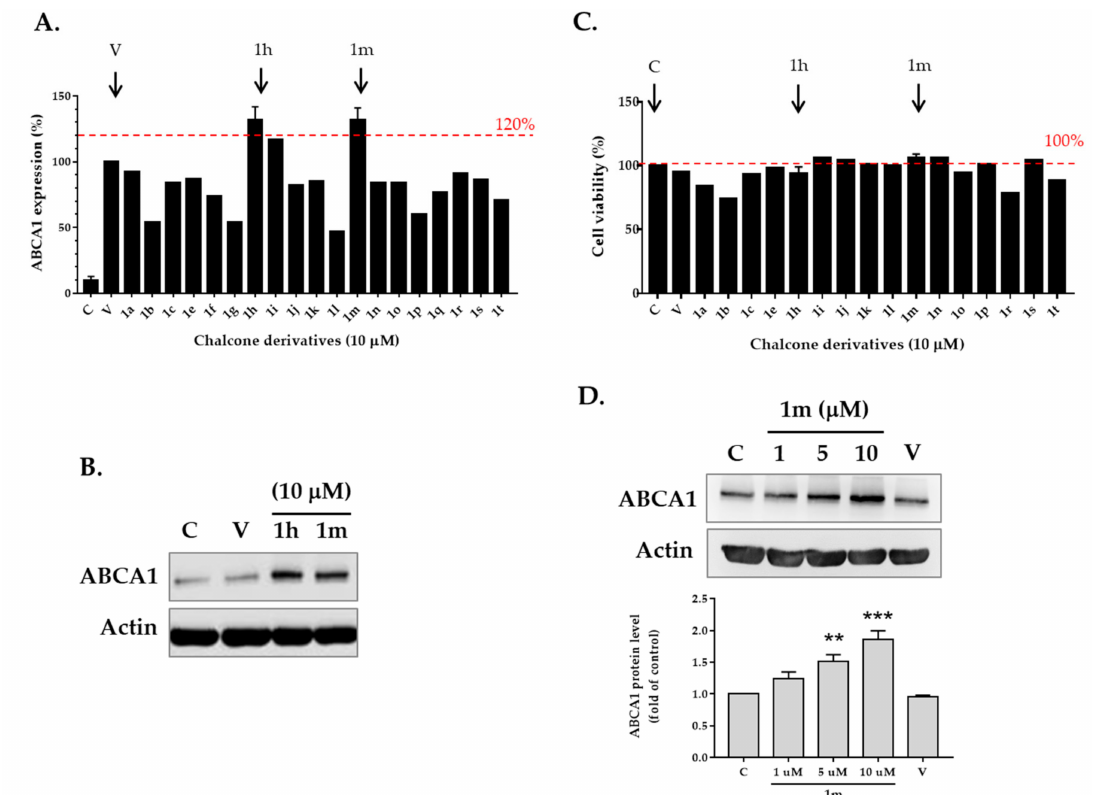
Figure 2. Effects of chalcone derivatives on the expression of ABCA1 in human THP-1 macrophages. ( A ) Human THP-1 macrophages were treated with control ( C ), vehicle (V; 0.1% DMSO) and various chalcone derivatives at a concentration of 10 µ M for 24 h; cells were then washed and stained with ABCA1 antibody. The expression of cell surface ABCA1 was analyzed using flow cytometry. ( B ) Cell lysates were collected after treatment with the selected chalcones 1h and 1m at 10 µ M for 24 h. The expression of ABCA1 and Actin in THP-1 macrophages was determined by Western blot. ( C ) THP-1 macrophages were incubated with vehicle (0.1% DMSO) or chalcone compounds (10 µ M) for 24 h. Cells were then incubated with MTT for six hours. Cell viability was measured by the amount of dissolved reduced MTT crystals using an enzyme-linked immunosorbent assay reader; 1m was nontoxic to THP-1 macrophages and was selected for subsequent studies. ( D ) THP-1 macrophages were treated with the indicated concentrations of 1m . The expression of ABCA1 protein was determined by Western blot. Data are shown by representative bands and presented as the mean ± SEM of three independent experiments in triplicate after densitometric analysis. (** p < 0.01, *** p < 0.001 vs.